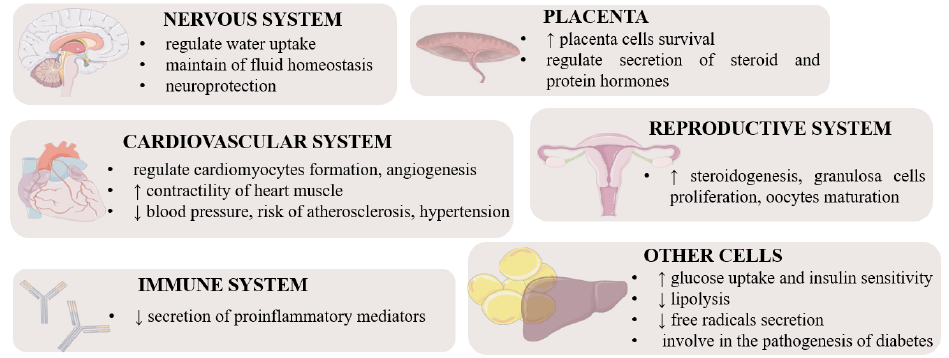
Figure 2. Pleiotropic function of apelin and ELABELA in different tissues [44]. Stimulation, ↑ ; inhibition, ↓ .